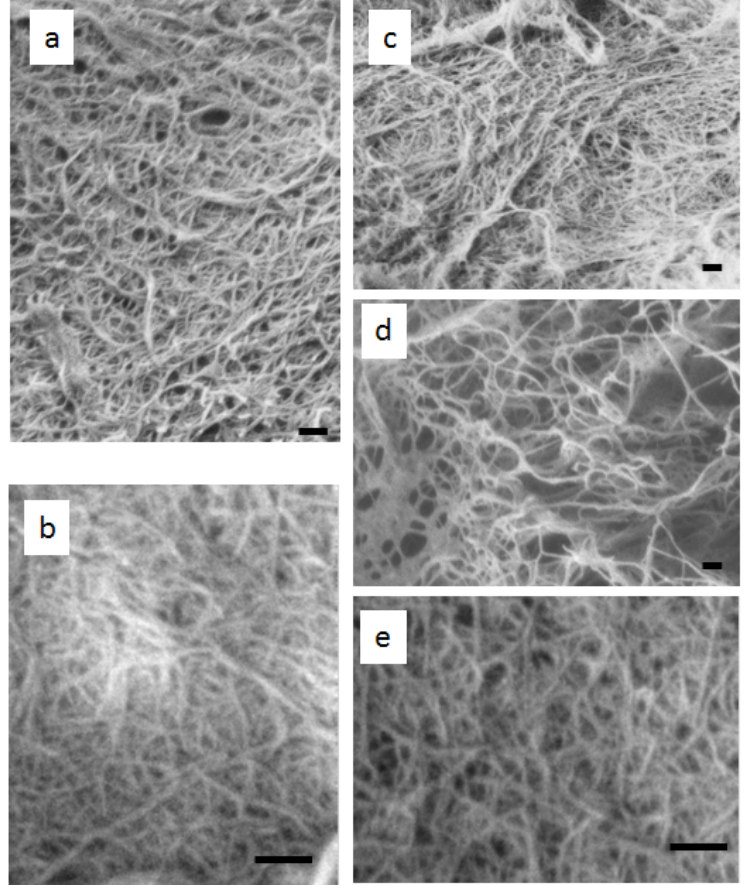
Figure 3. FE-SEM micrographs of chitin nanofibers prepared from ( a ) Pleurotus eryngii ( b ) Agaricus bisporus ( c ) Lentinula edodes ( d ) Grifola frondosa ( e ) Hypsizygus marmoreus . The scale bars are 200 nm in